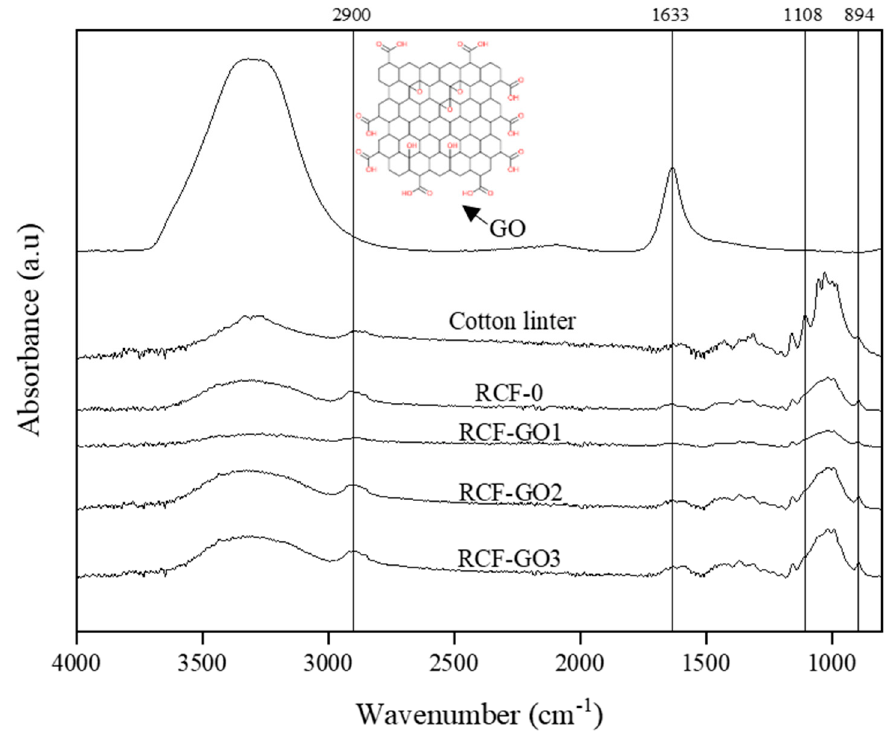
Figure 4. FTIR spectra of GO, cotton linter, RCF − 0, and RCF −